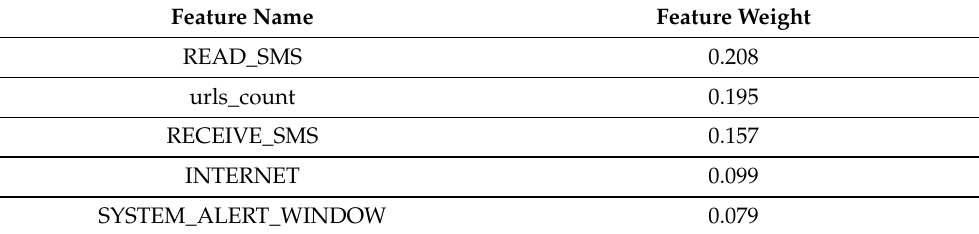
Table 2. The most relevant features with weights calculated by the gradient boosting classifier.